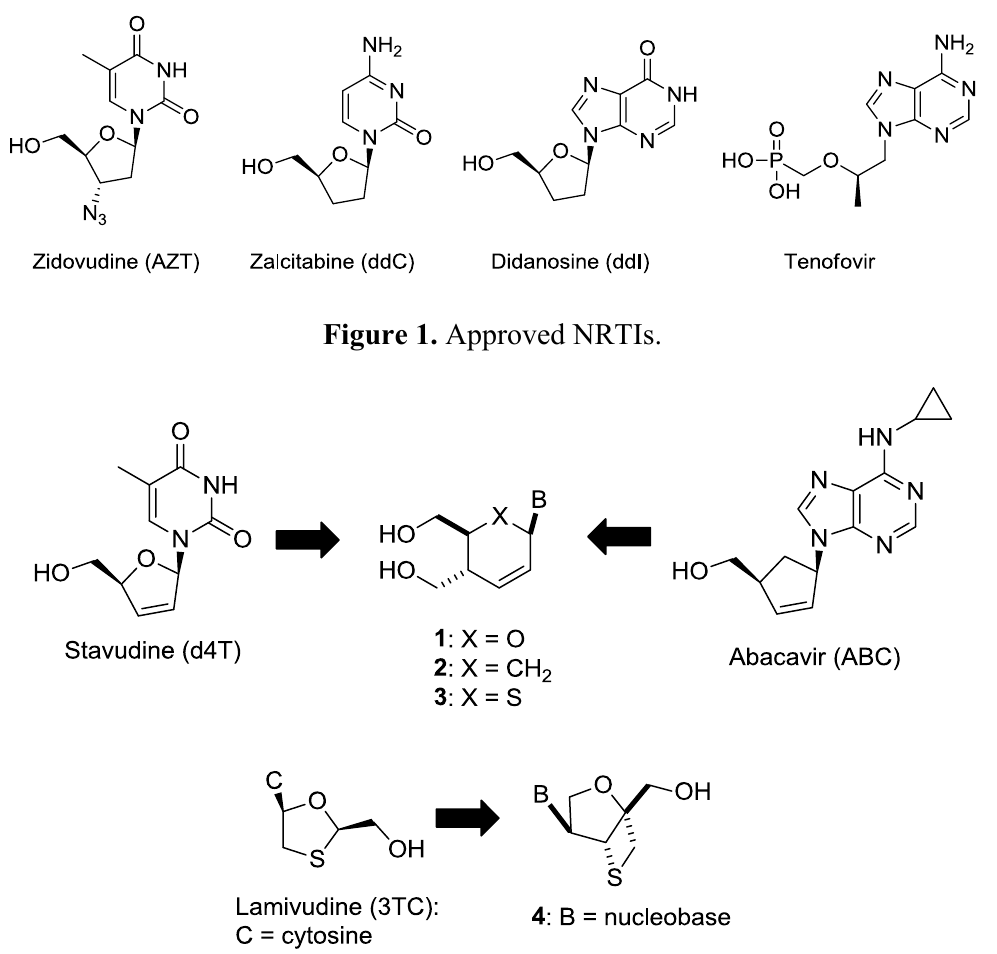
Figure 1. Approved NRTIs.